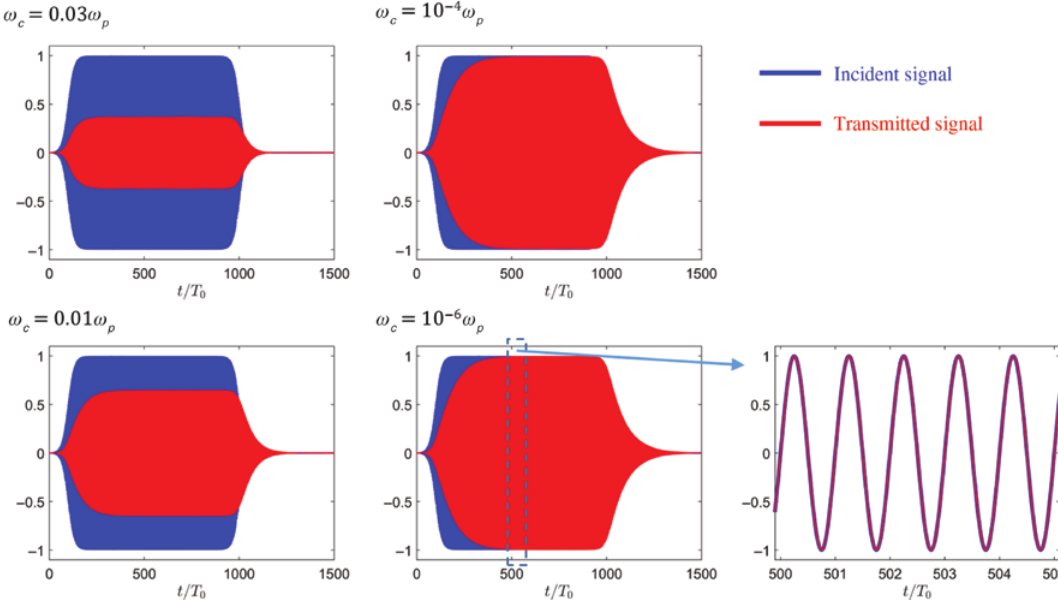
Figure 3: Transient response of ENZ metasurfaces with photonic doping. Incident (blue) and transmitted (red) signals passing through an ENZ metasurface, photonically doped with a 2D dielectric rod discussed in Figure 1, for four increasingly small amounts of loss as prescribed by the collision frequencies ω = 10 −6 ω ω . The incident signal corresponds to the ON-OFF pulse described in Equation (3). Numerical simulations describe how the tun- c p neling effect is established after a transient time is passed once the incident pulse is switched on and how the energy of the system is released after the pulse is switched off. The right bottom inset includes a zoom-in on the incident and transmitted signals once the steady state of the system has been established. The steady-state response of the system is characterized by EMNZ tunneling, i.e. near-unity trans- mission with zero-phase